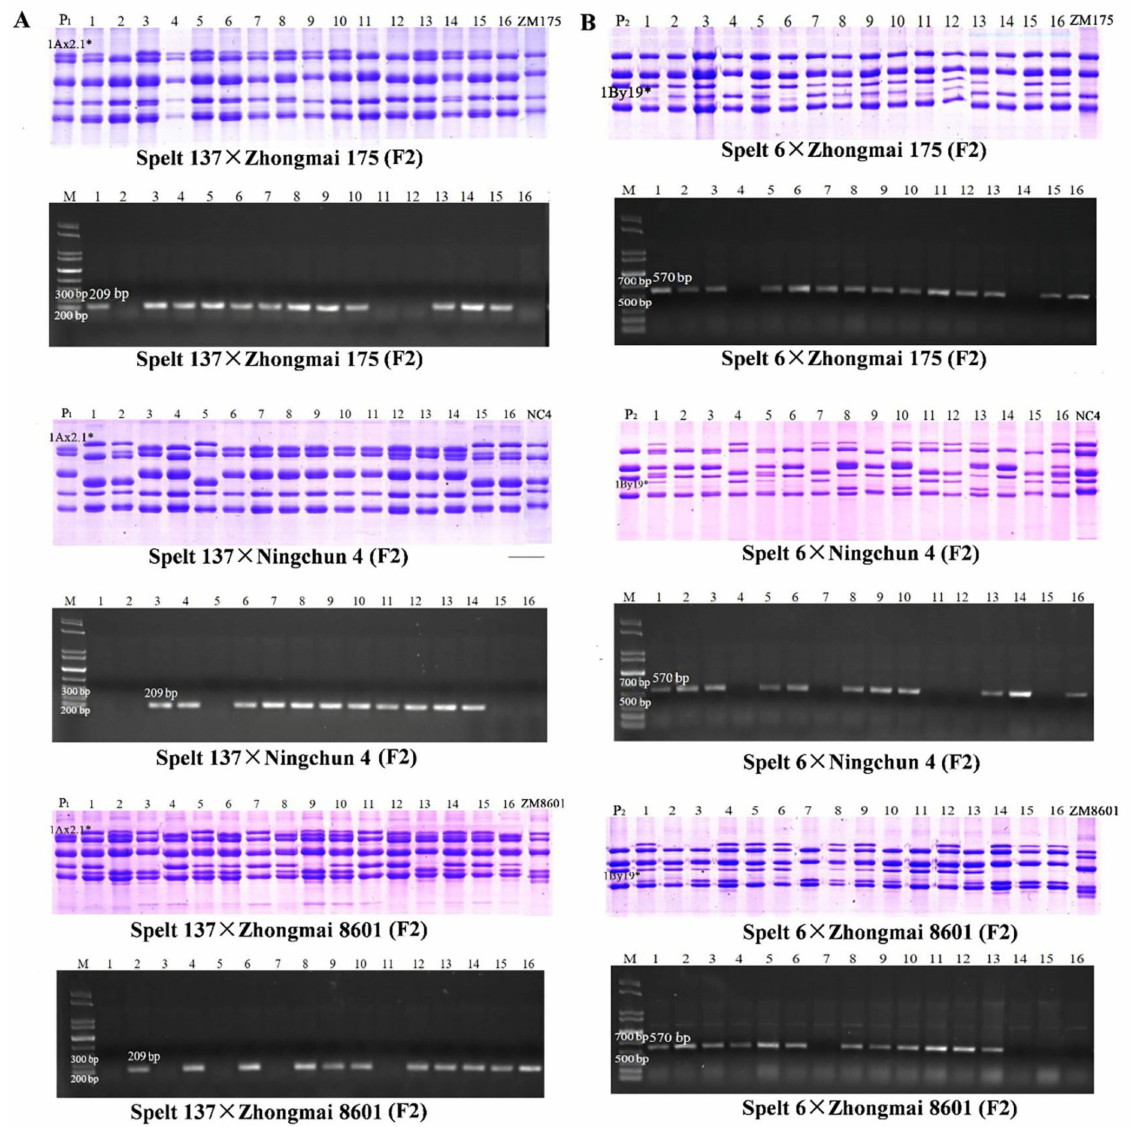
Figure 7. Validation of the SNP-based molecular marker for 1Ax2.1* ( A ) and 1By19* ( B ) genes in the F2 populations from crossing between spelt wheat and bread wheat varieties. 1Ax2.1* and 1By19* subunits and their special amplification fragments 209 bp and 570 bp are indicated. P 1 : Spelt 137; P 2 : Spelt 6; ZM175: Zhongmai 175; NC4: Ningchun 4; ZM8601: Zhongmai